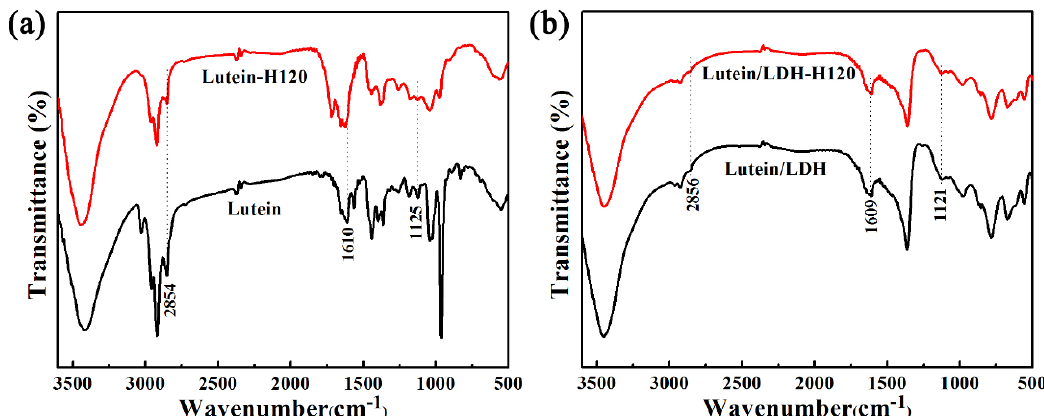
Figure 4. FTIR spectra of lutein and lutein/LDH before ( a ) and after ( b ) being heated at 120 °C for 4h, respectively.